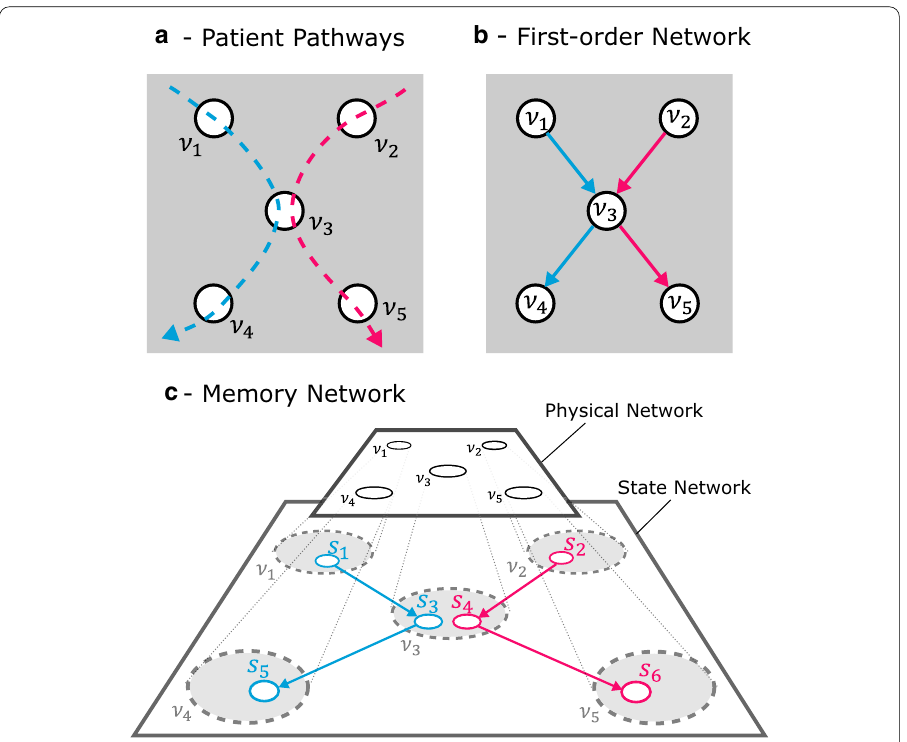
Fig. 1 Illustration of transitive dependence encoded into memory network. a Two sets of typical patient pathways, largely independent, but passing through the same ward as an intermediate point in their pathways. b First-order representation of a without any memory ( c ) Memory network representation a , whereby a physical node network maps to state nodes, which encode transitive dependence of the patient pathways and constrain a random walkers